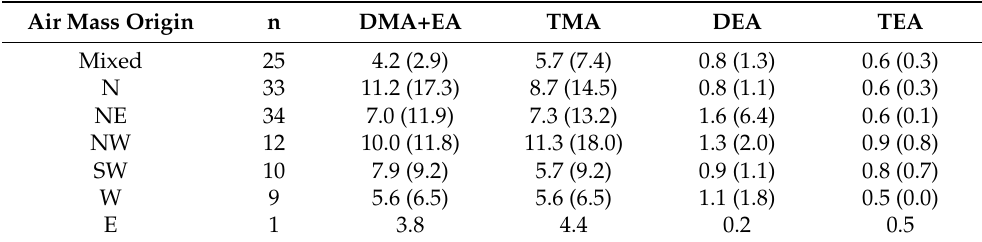
Table 5. Amine concentrations (average and standard deviation in parentheses) for each air mass sector; n is the number of samples per sector. Mixed air mass origin corresponds to air masses having variable origin during the 36 h of